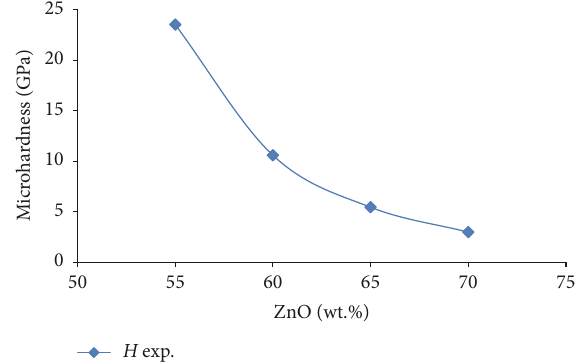
Figure 7: Fractal bond connectivity versus wt.% of ZnO in ZnO–SiO 2 samples.